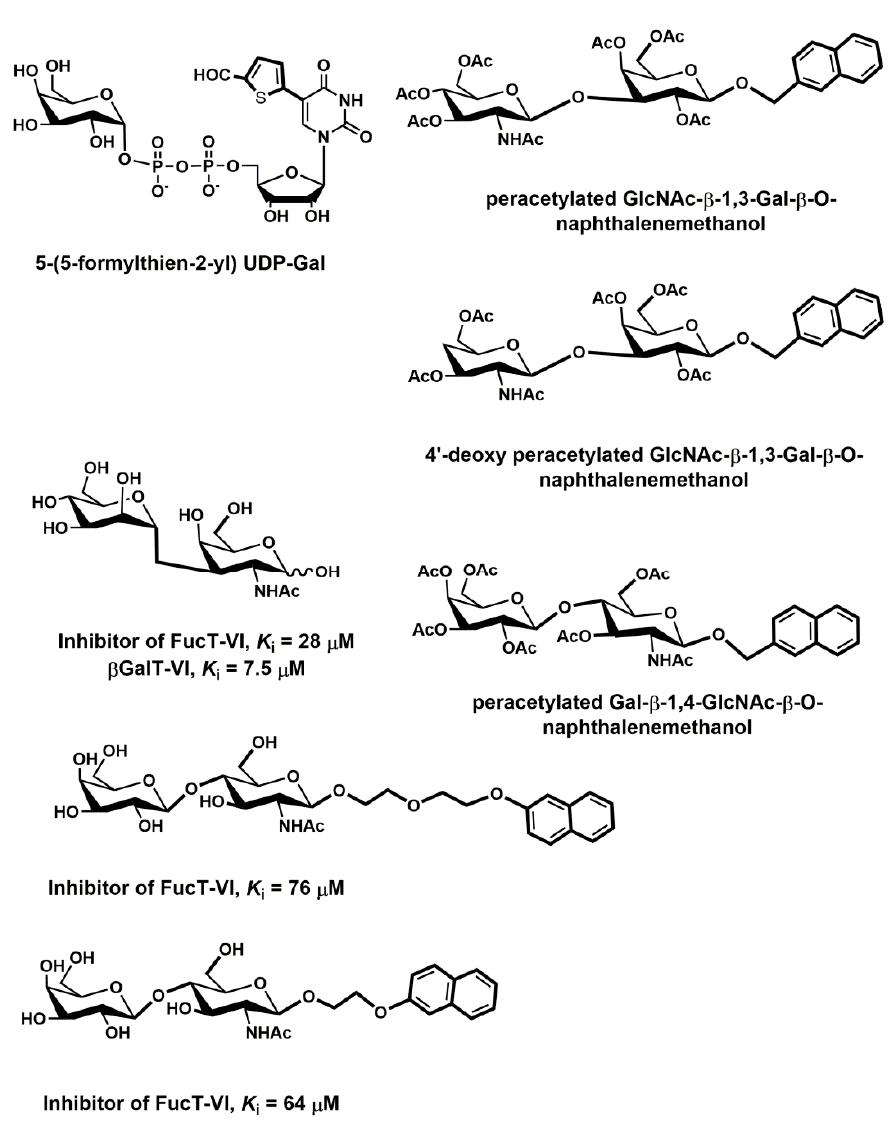
Figure 18. Schematic representation of substrate-based GT inhibitors.